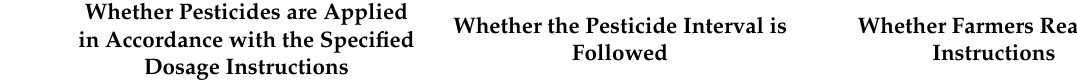
Table 6. Model regression results of the peach farmers with different planting